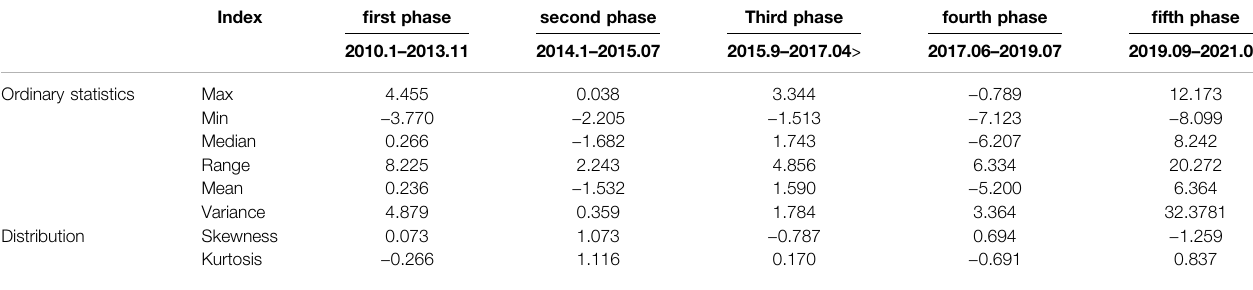
TABLE 7 | Segmented statistical description of low-frequency components of hog ’ s